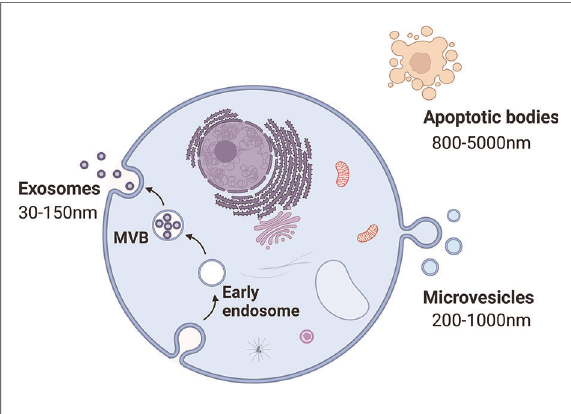
FIGURE 3 The biogenesis of each subtype of EVs. Apoptotic bodies (800 – 5,000 nm in size) are the result of the disintegration of apoptotic cells. Microvesicles (200 – 1,000 nm in size) arise from the plasma membrane. Exosomes (30 – 150 nm in size) originate from